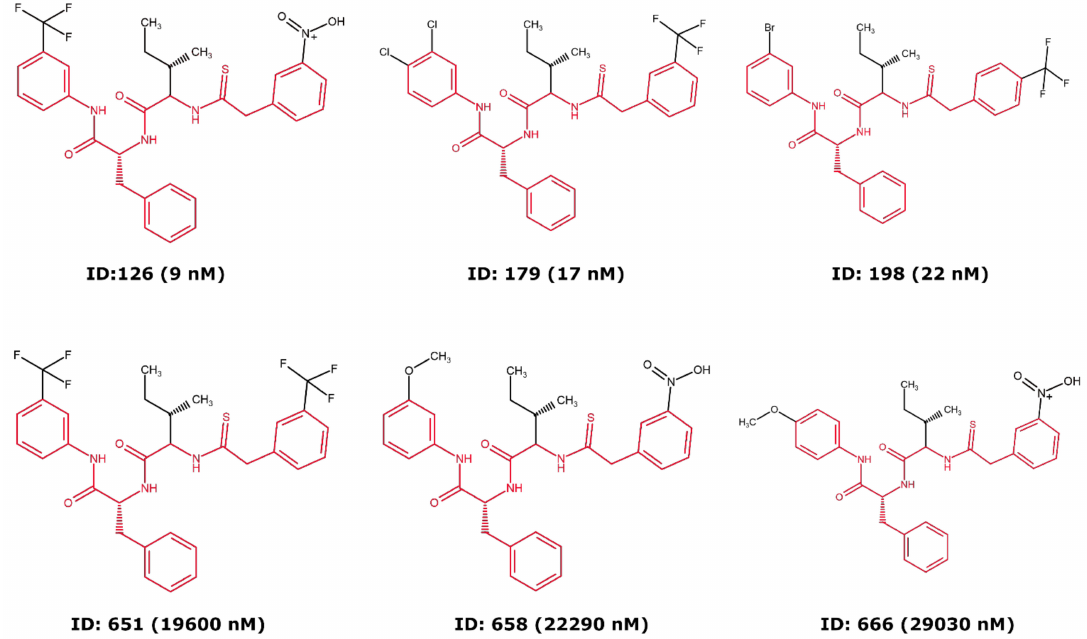
Figure 7. Compounds with the main, largest sca ff old shared between class A (top) and D